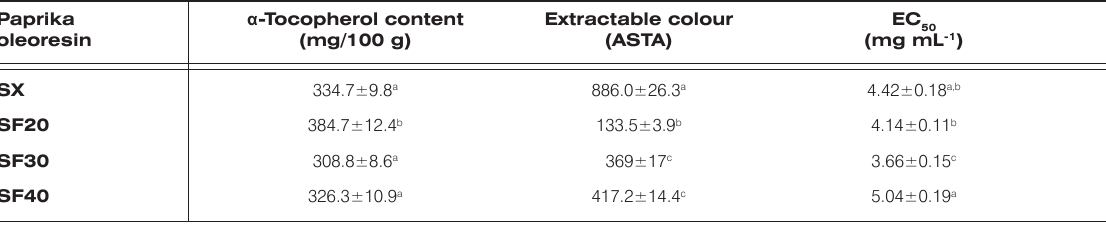
Table 1. α -Tocopherol content, extractable colour and superoxide anion radical scavenging activity of paprika oleoresins. Paprika α -Tocopherol content oleoresin (mg/100